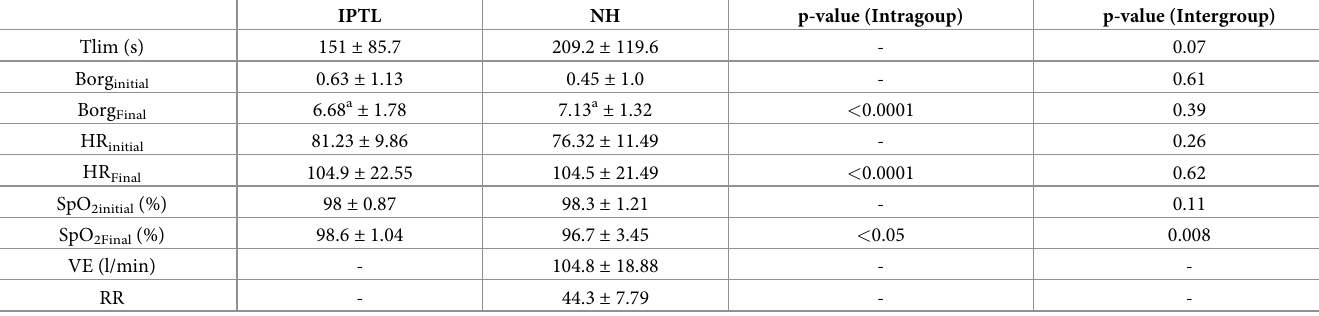
Table 2. Parameters from endurance